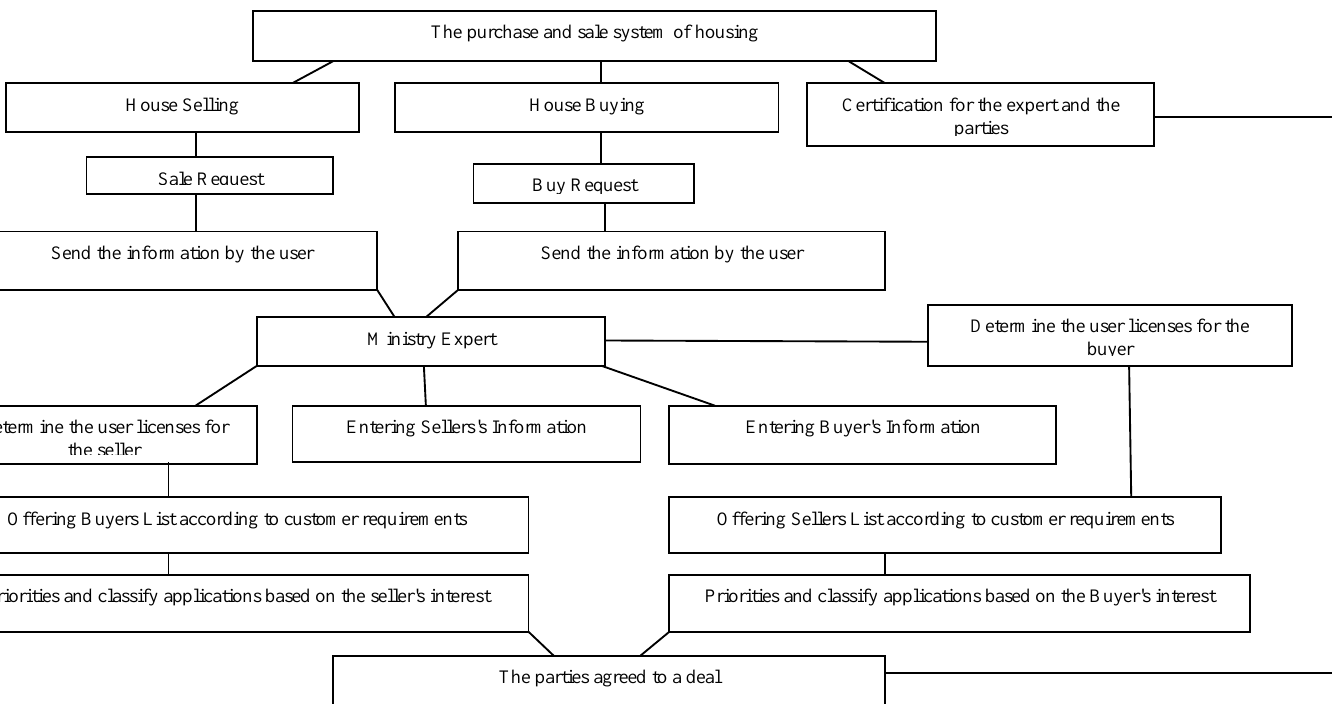
Figure3 . Goal model and the purchase and sale system of